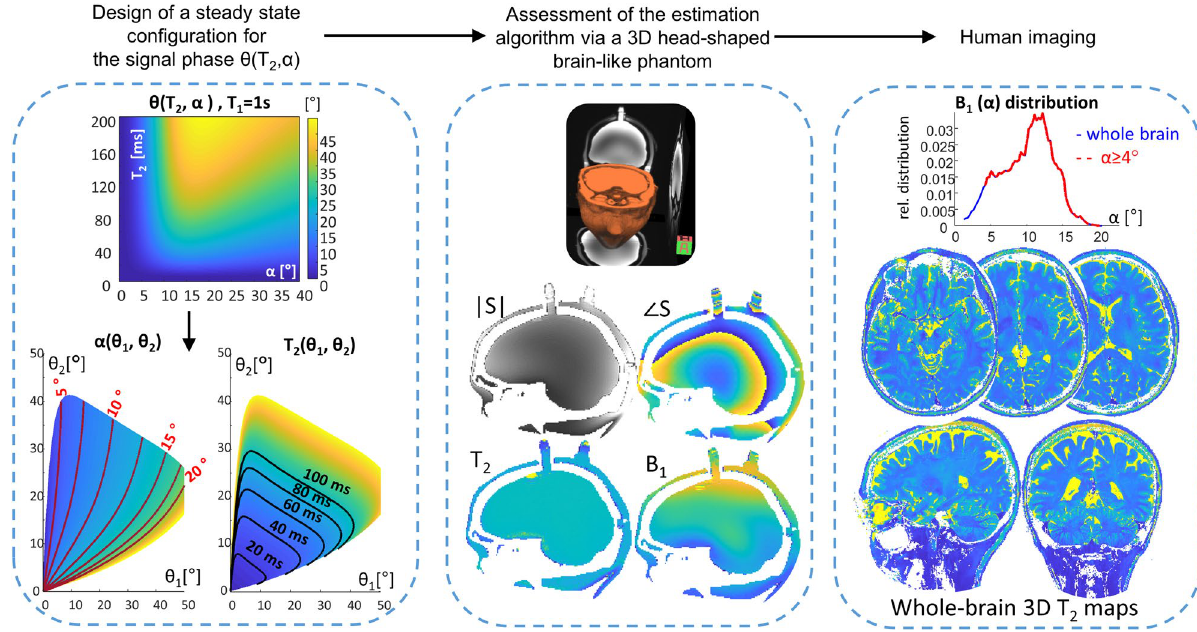
Figure 1. Schematics of the steady state method for T 2 and RF field estimation—its design and verification. Starting from simulations, through assessment of the estimation algorithm, via a 3D head-shaped brain-like phantom, to human imaging. Left—a design of a steady-state configuration based on Bloch simulations that provides θ(T 2 ,α) for specific φ inc, which was thereafter utilized to generate T 2 and α in the 2D space (θ 1 , θ 2 ). The new space allows to extract T 2 and α from θ 1 and θ 2 . Center—the estimation algorithm was assessed via simulations and brain-like phantom measurements. In these measurements, a realistic signal S was acquired, providing |S| and ∠ S , from which the T 2 and α (or B 1 distribution) were estimated. Right—human imaging at 7 T MRI provided high-resolution whole-brain T 2 maps, while coping with the B 1